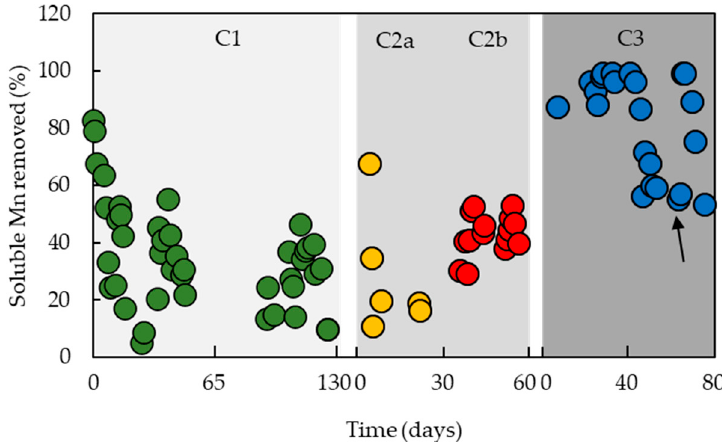
Figure 2. Variations in the percentage of manganese removed during the time course of the experi- ment. Key: phase C1 (green): 1-column system pH 5.0, HRT 12 h; C2a (yellow): 1-column system pH 6.5, HRT 12 h; C2b (red) 1-column system pH 6.5, HRT 24 h and C3 (blue): 2-column system pH 6.5, HRT 45 h. The arrow indicates where yeast extract (final concentration 100 mg L − 1 ) was added to the influent liquor.